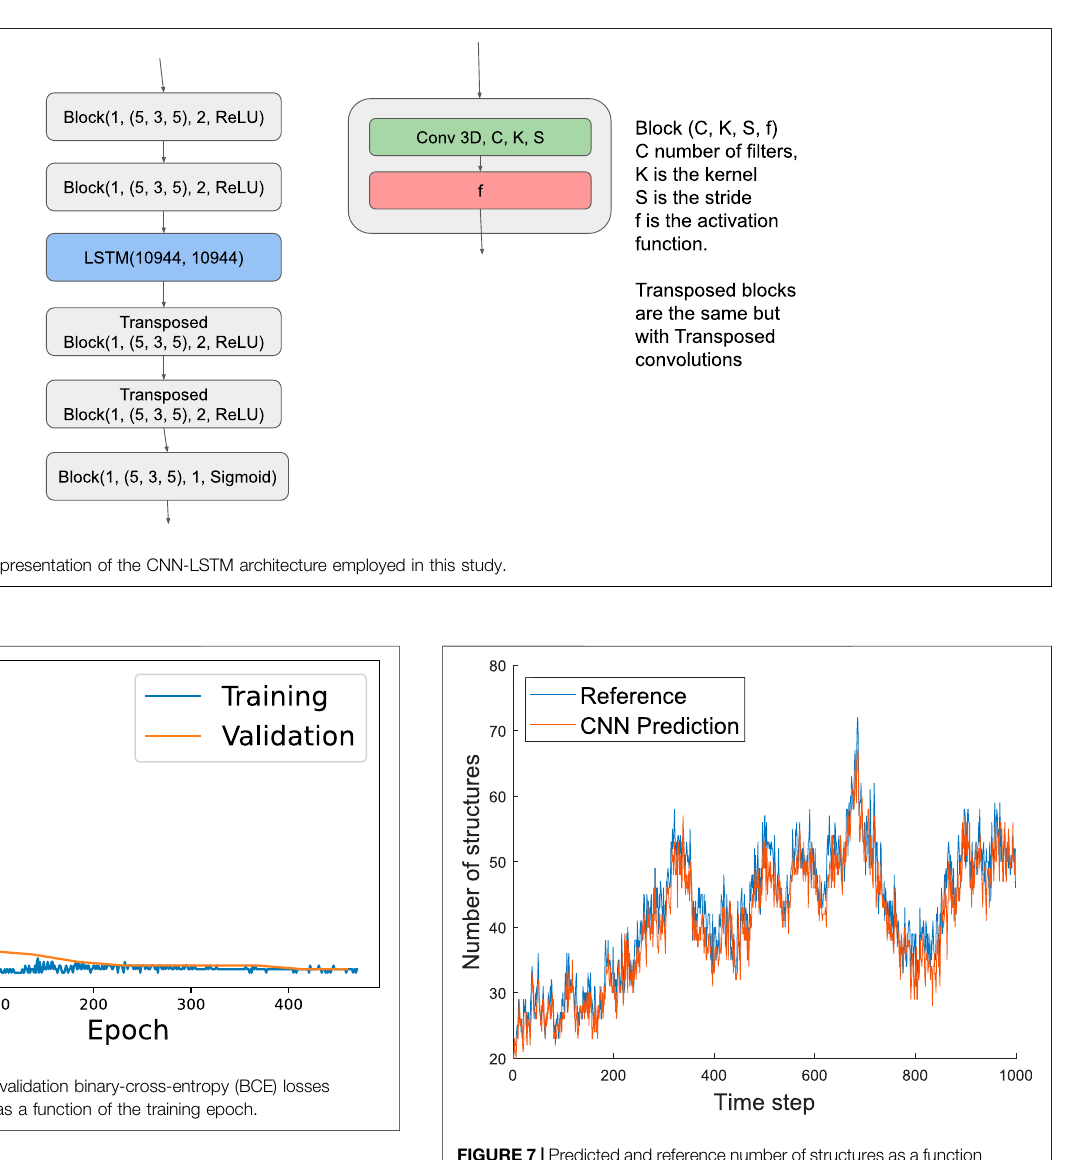
FIGURE 7 | Predicted and reference number of structures as a function ofthetimestepfortheinnerregion, i.e.y ≤ 0.2.Weobservethatthenumberof structures is not constant over